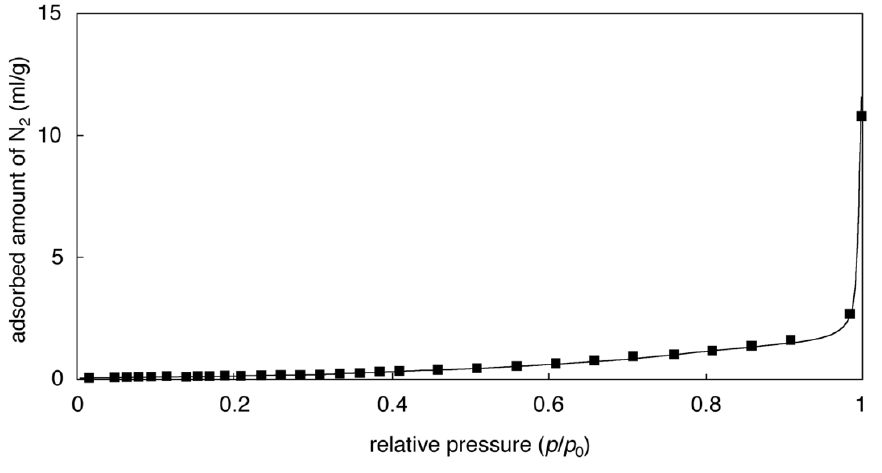
Figure 6. Nitrogen adsorption isotherm of [Ru 2 (CH 3 COO) 4 Au(CN) 4 ] n ( 1 ). The solid line is a guide for the eye.